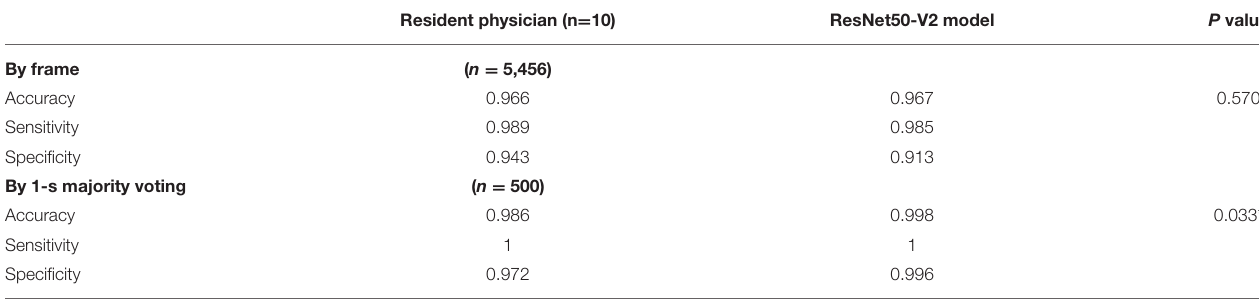
TABLE 3 | Comparison of resident doctor and model performance for ascites